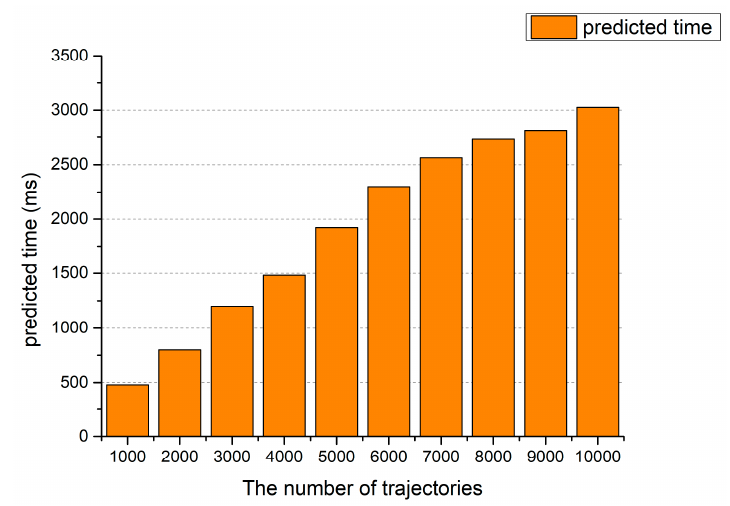
Figure 8. Time consumption of different numbers of historical trajectories.